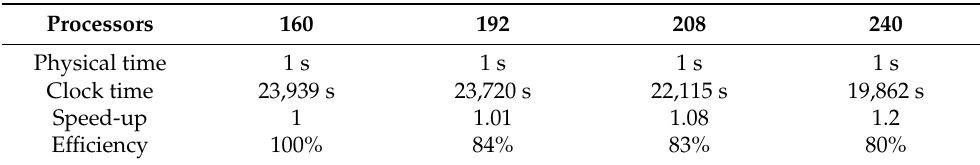
Table 5. Efficiency of OpenFOAM parallelization for a test case of the Canadian ship A at R15 ◦ wind with 43.4 million